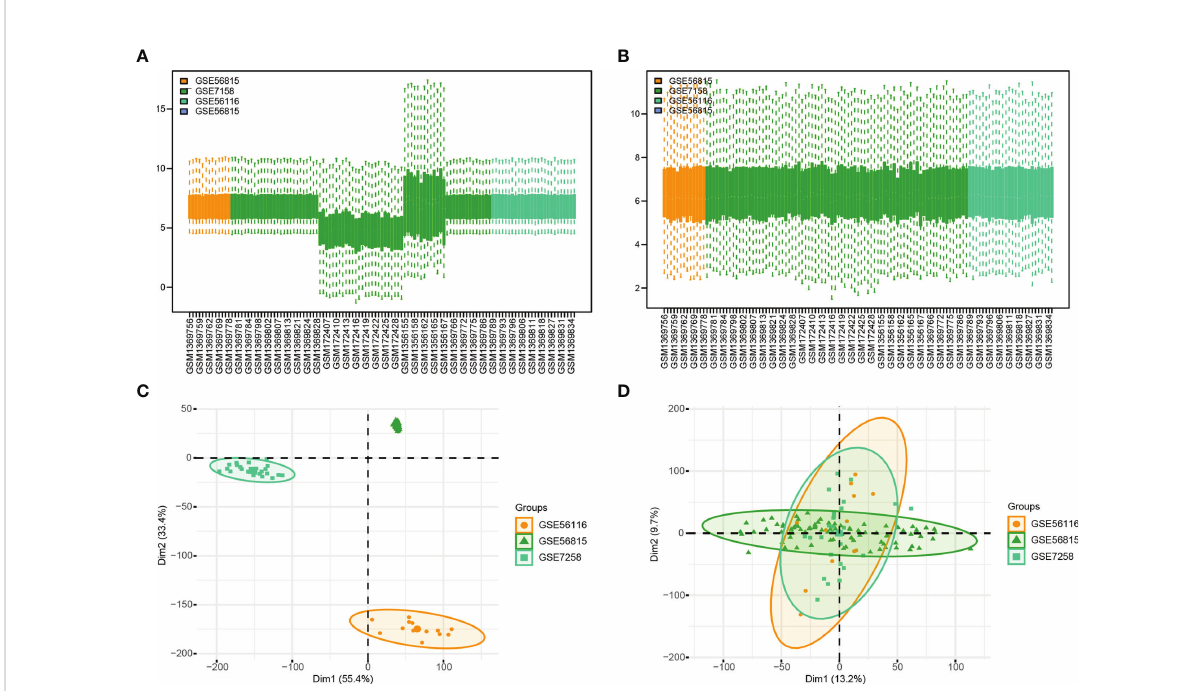
FIGURE 2 Gene Expression Omnibus (GEO) data preprocessing. (A, B) are the differences in data distribution before and after data set processing. (C, D) results from PCA dimensionality reduction before and after data set